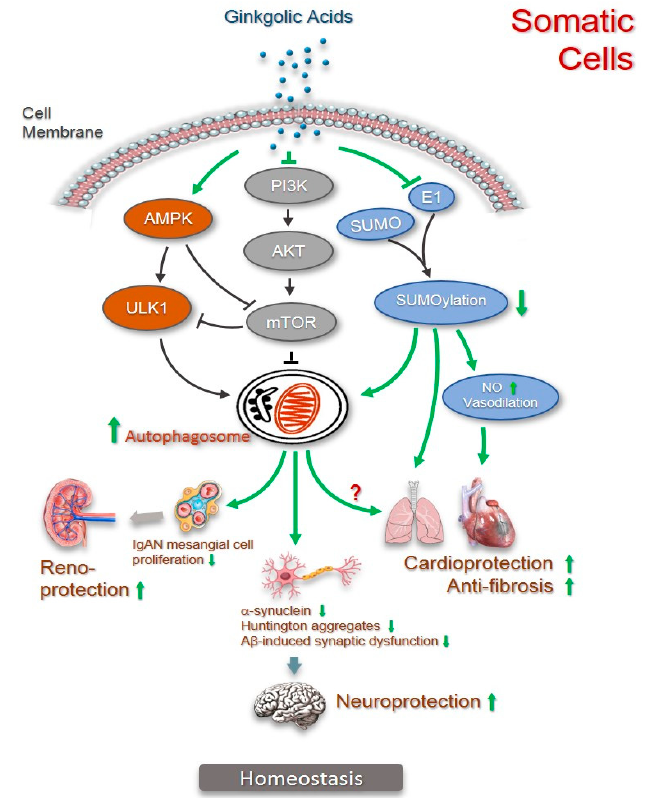
Figure 7. Involvement of autophagy in the mechanisms for anti-fibrosis, cardioprotection, renoprotection, and neuroprotection by ginkgolic acids. As the key regulators, the PI3K/Akt/mTOR signaling pathway negatively and the AMPK/ULK1 signaling pathway positively regulate autophagy (illustrated in black). Through inhibition of PI3K/Akt/mTOR pathway and activation of AMPK/ULK1 pathway, ginkgolic acids upregulate autophagy (illustrated in green). SUMOylation is activated by SUMO-activating enzyme (E1)-initiated cascade that adds SUMO peptides to targeted proteins (illustrated in black). Functioning as SUMO1 specific inhibitor, ginkgolic acids inhibit SOMUylation by inhibiting E1, leading to increase in nitric oxide (NO) and vasodilation improvement. Inhibition of SUMOylation also activates autophagy to prevent myocadiac fibrosis. Since SUMOylation inhibition contributes to the protection of lung fibrosis by ginkgolic acids, autophagy activation caused by SUMOylation inhibition cannot be excluded. Ginkgolic acids-induced SUMOylation inhibition leads to upregulation of autophagy in IgA nephropathy (IgAN) that lessens proliferation of mesangial cells (illustrated in green). The same mechanism applies to the clearance of α -synuclein and mutant Huntington protein aggregates as well as A β -induced synaptic dysfunction rescue in neuronal cells (illustrated in green).